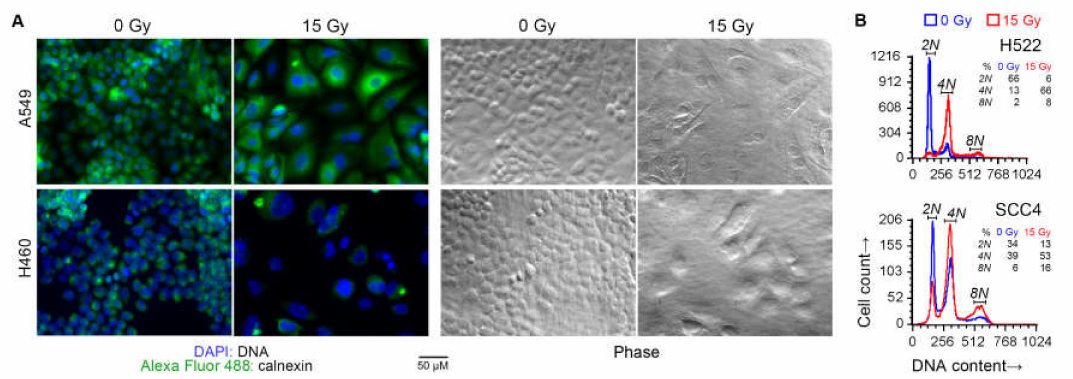
Figure 4. Cell cycle arrest following radiation treatment. Indicated human cancer cell lines were treated with one dose of 15 Gy X-rays or left untreated (0 Gy). After four days, the DNA content of adherent cells was examined. ( A ) Overlaid green and blue fluorescence and phase contrast light microscopy images of representative fields are shown. Cells were fixed and permeabilized, and stained with an Alexa Fluor 488 green-fluorophore-conjugated monoclonal antibody against the endoplasmic-reticulum-resident calnexin protein, and the blue fluorescent DNA-binding dye 4’,6-diamidino- 2 -phenylindole (DAPI). ( B ) Histograms of DNA content of singlet cells are shown. Adherent cells were collected by scraping, fixed, stained with propidium iodide (PI) in a bu ff er with RNAse, and examined by fluorescence flow cytometry. DNA content was measured as orange fluorescence from PI–DNA binding. Noted are fractions of cells with 2N, 4N, and 8N DNA content (approximately diploid, tetraploid, and